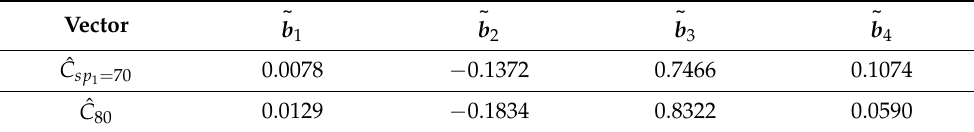
parameters’ values (procedure 1